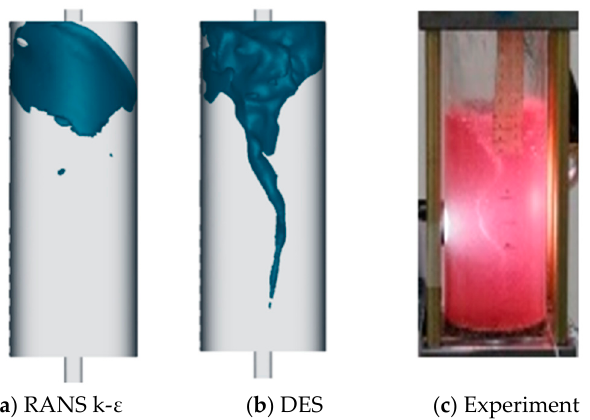
Figure 5. Comparison of liquid surface shape between experiments and CAE analysis.